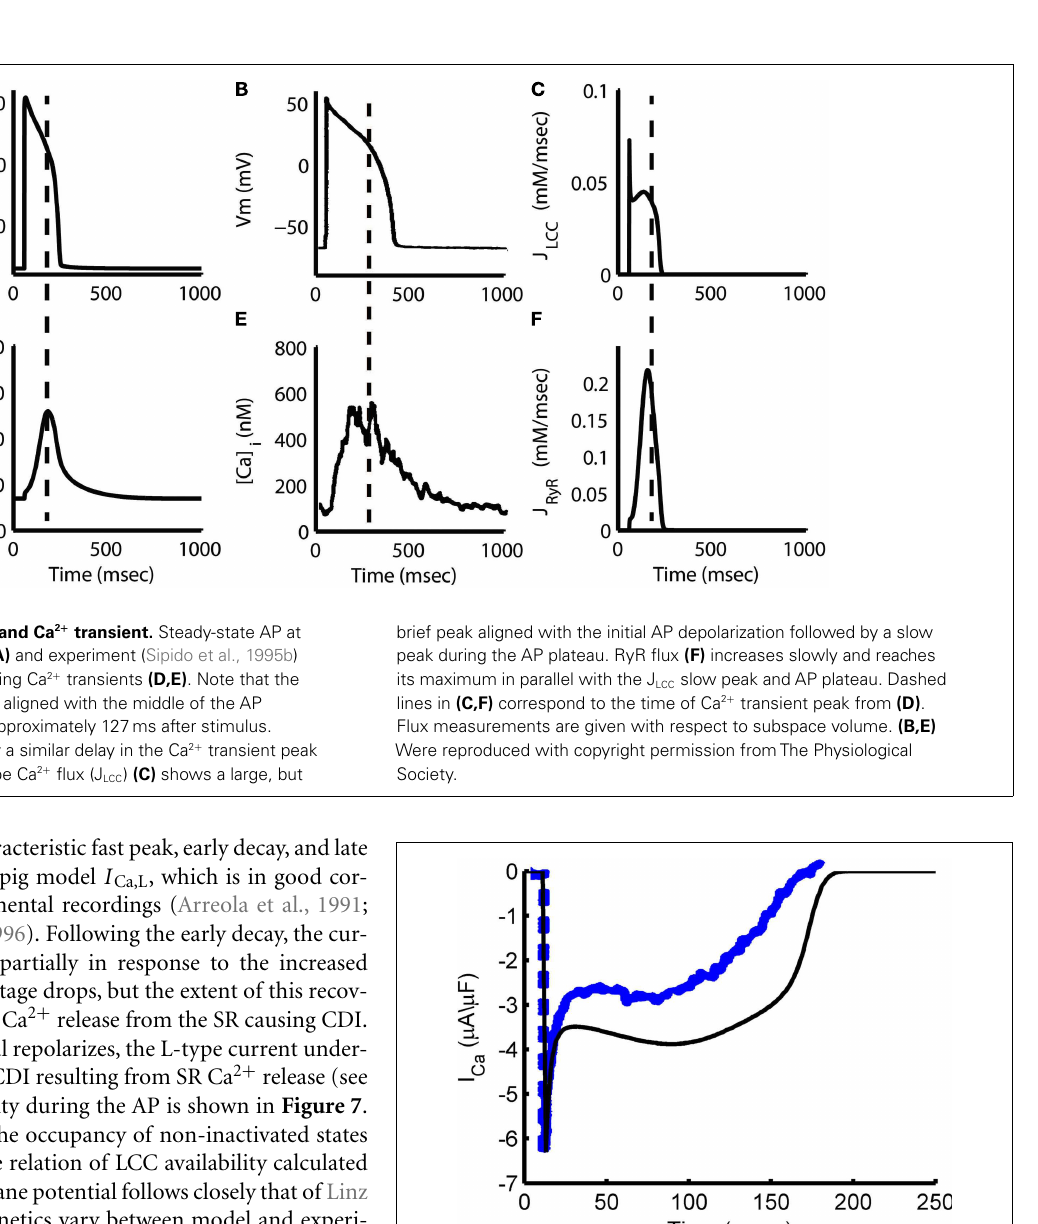
FIGURE 6 | I Ca,L during theAP. Simulated I Ca,L trace during steady-state AP at 1Hz pacing (black) and experimental I Ca,L trace from a guinea pig ventricular myocyte undergoing 1Hz pacing at 35–37˚C (blue). Blue trace is reproduced from Grantham and Cannell (1996) by copyright permission of the American Heart